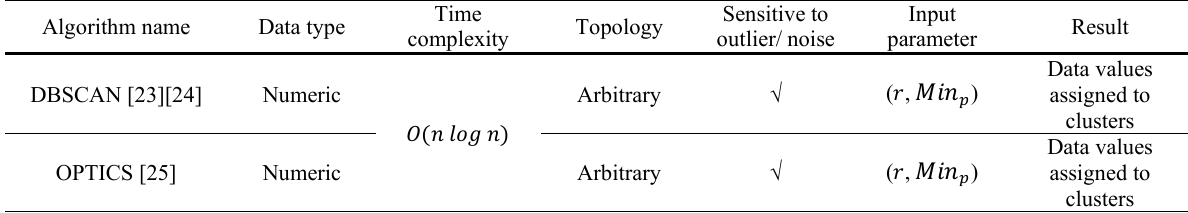
Table 3. Most Common Density-Based Clustering